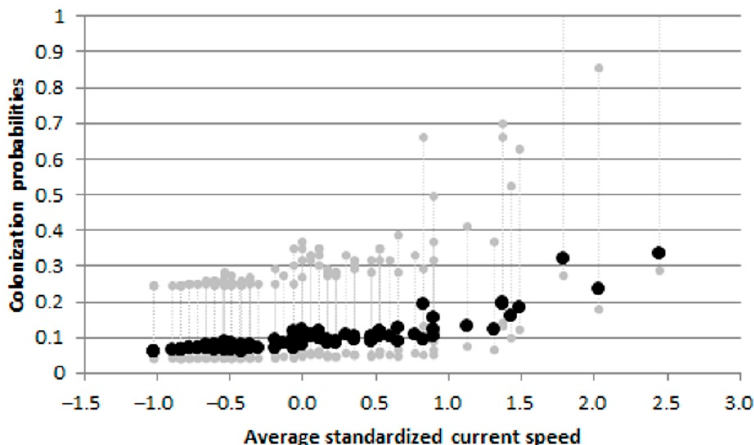
Figure 11. Gobio gobio : effects of average current speed on colonization probabilities from the best informative models. Dashed gray lines indicate upper and lower 95% confidence intervals.